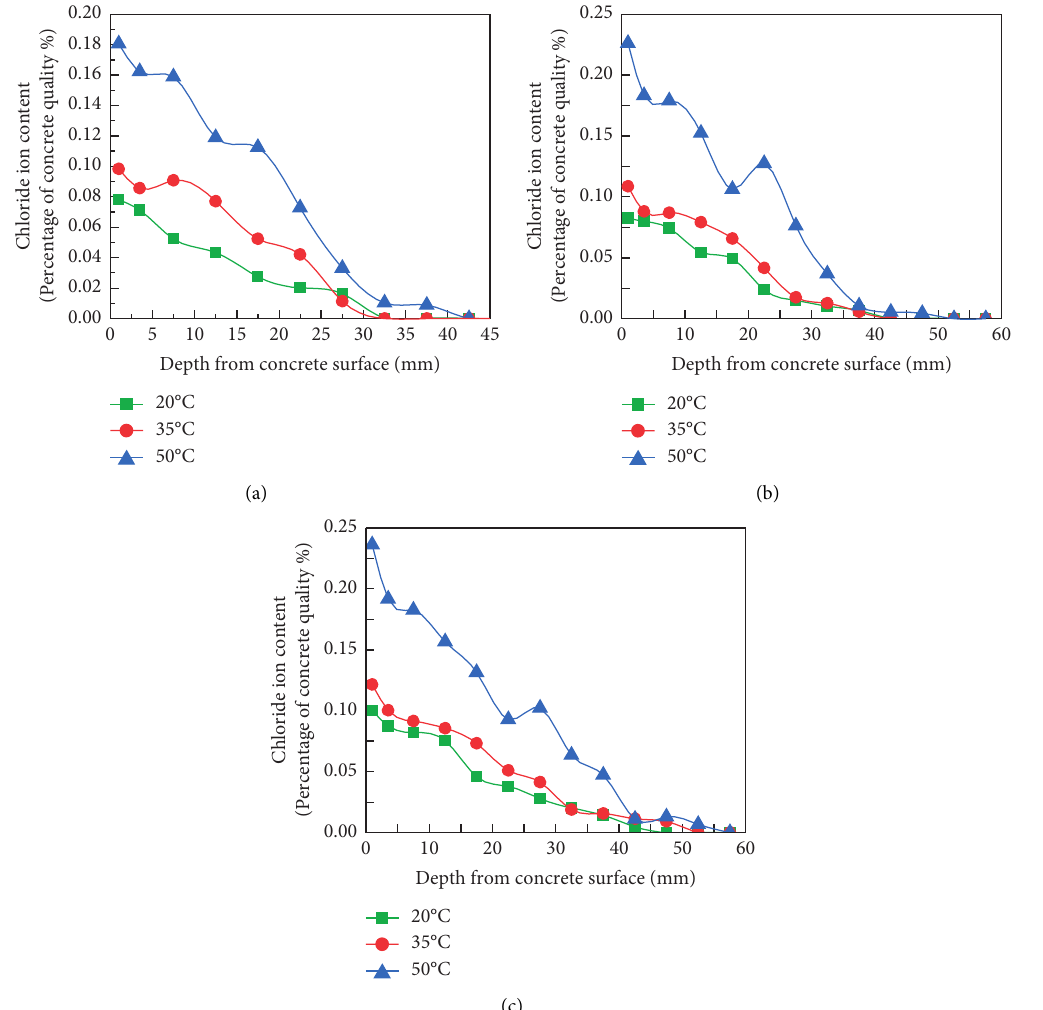
Figure 3: Distribution of chloride content in concrete under different temperatures: (a) 20 d, (b) 40 d, and (c)